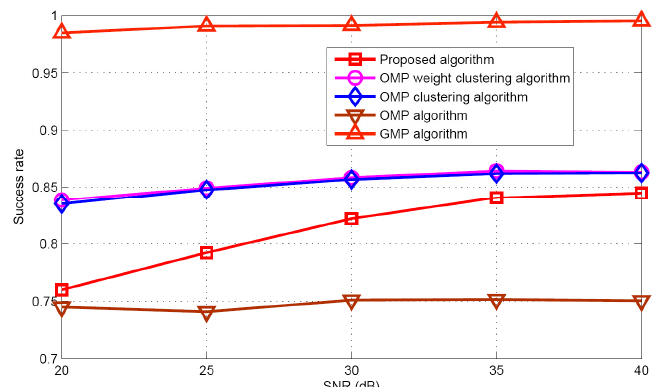
Figure 12. Success rate comparison ( D =2.8 d).